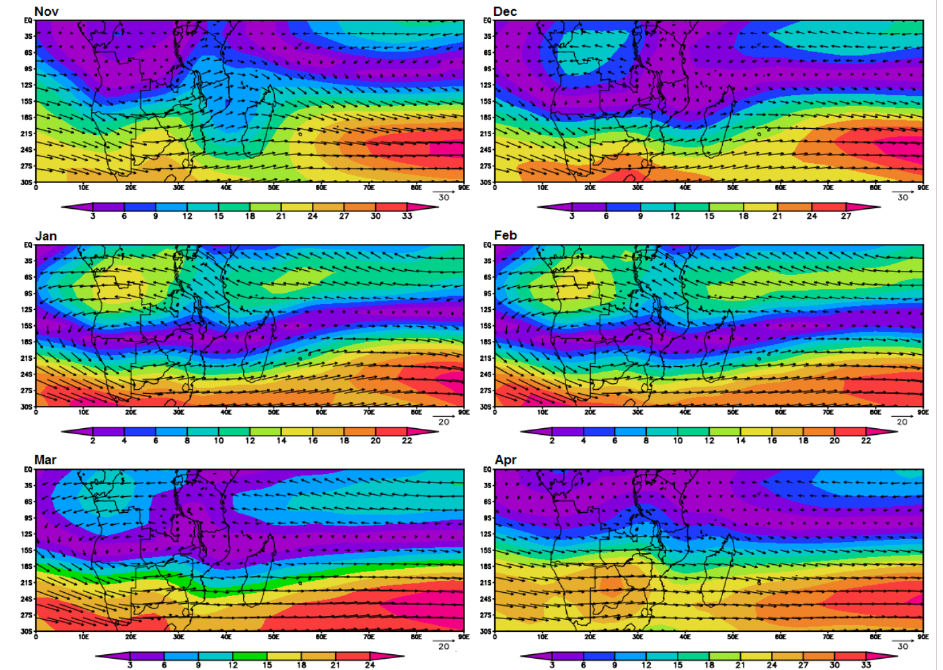
Figure 3. Same as Figure 1, but for mean monthly VWS.